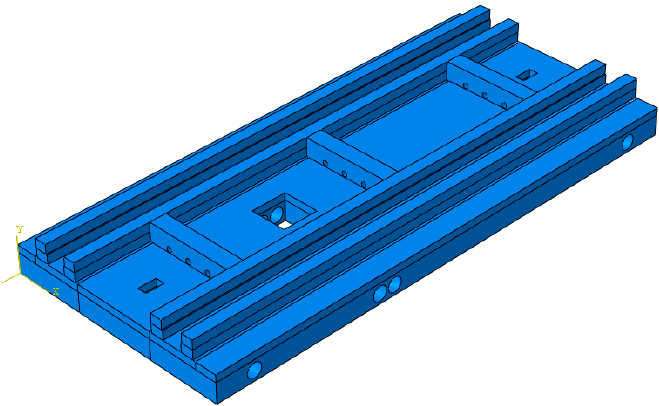
Figure 7. The NFET model with the cable and drainage